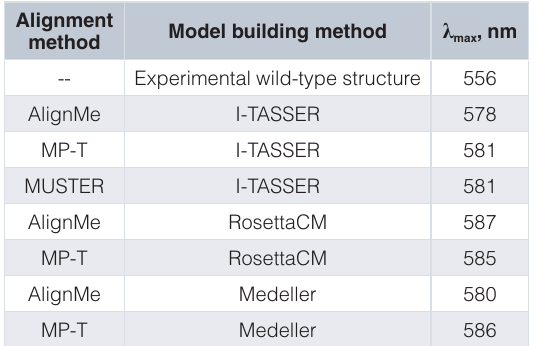
studies, we obtained a 29 nm shift for the absorption maximum of halorhodopsin from N.pharaonis 23 , a 25 nm shift for the absorption maximum of archaerhodopsin-2 and a 39 nm shift for the channelrhodopsin-2. The model with the smallest deviation was predicted by I-TASSER algorithm with AlignMe alignment (Figure